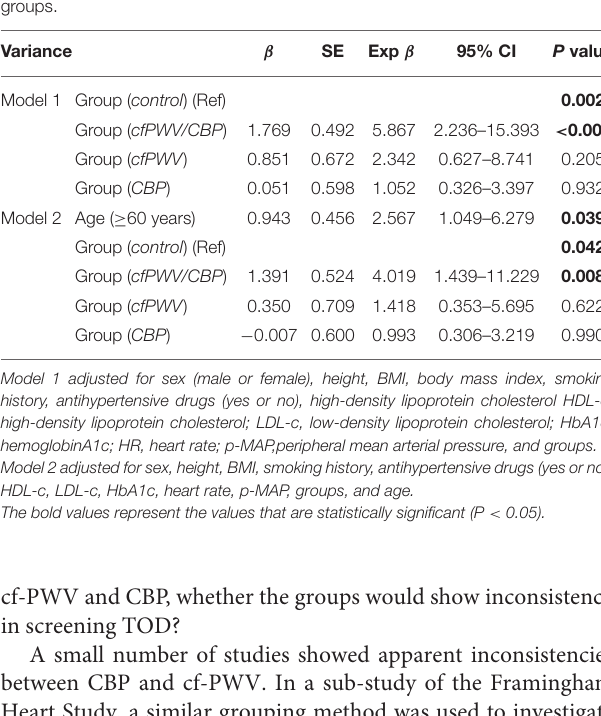
TABLE 5 | Subgroup analysis of eGFR abnormality adjusting for age in different